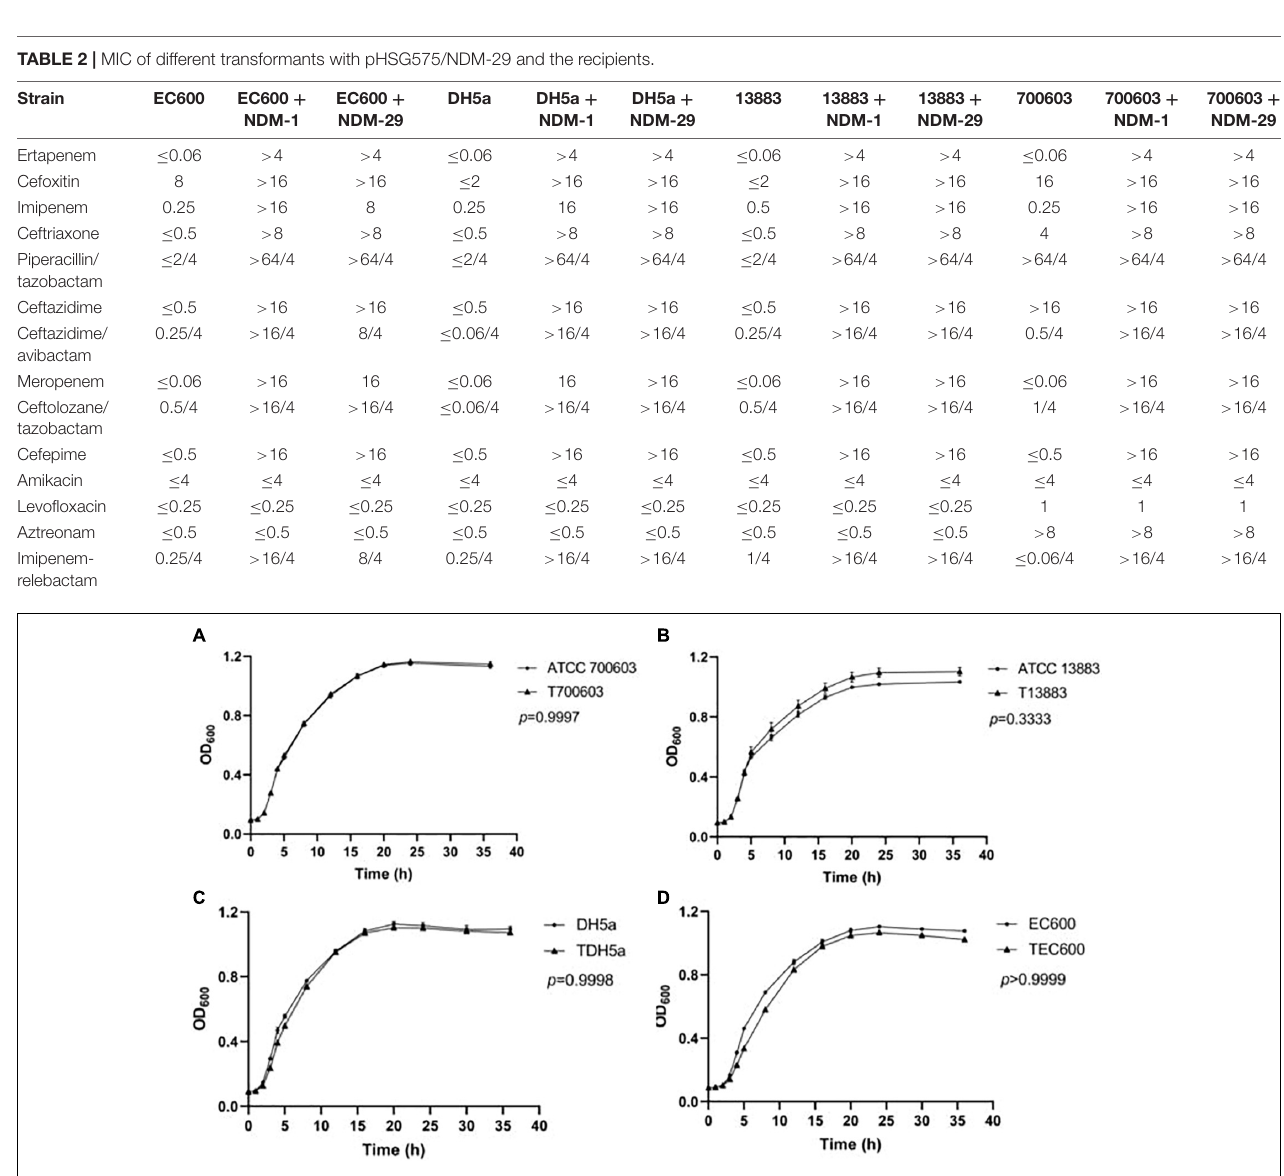
FIGURE 1 | Growth curve of transformants containing pNC225-NDM-29. One-way analysis of variance (ANOVA) followed by Tukey tests was used to define the statistical significance. P > 0.05 indicates no fitness cost was observed within pairs. (A) Growth curve of ATCC 700603 and corresponding transformant containing pNC225-NDM-29. (B) Growth curve of ATCC 13883 and corresponding transformant containing pNC225-NDM-29. (C) Growth curve of DH5a and corresponding transformant containing pNC225-NDM-29. (D) Growth curve of EG600 and corresponding transformant containing pNC225-NDM-29. T700603, transformant of ATCC 700603; T13883, transformant of ATCC 13883; TDH5 α , transformant of DH5 α ; TEC600, transformant of EC600.